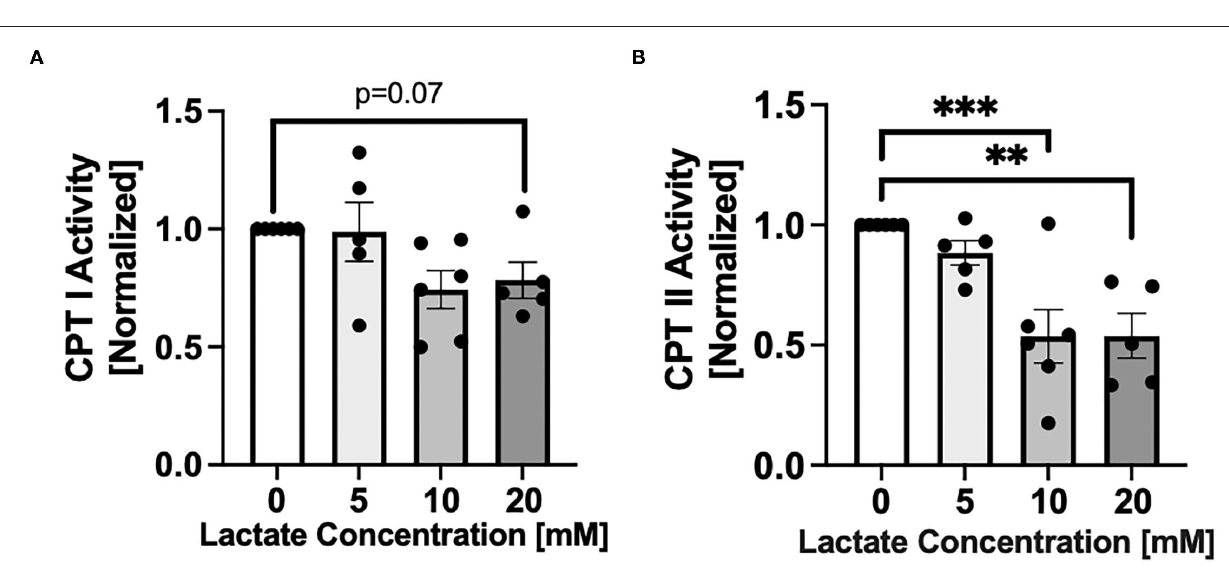
FIGURE 2 | Carnitine palmitoyl transferase (CPT) activity with chronic lactate treatment. NRVMs were treated for 48h with various concentrations of lactate and CPT I (A) or CPT II (B) assessed. Results are normalized to untreated cells with values for CPT I of 64.8 to 317.8 nmol/min/mg and for CPT II of 45.9 to 103.8 nmol/min/mg. n = average of 5–6 cell preparations; error bars show standard error of the mean, ** p < 0.01, *** p <